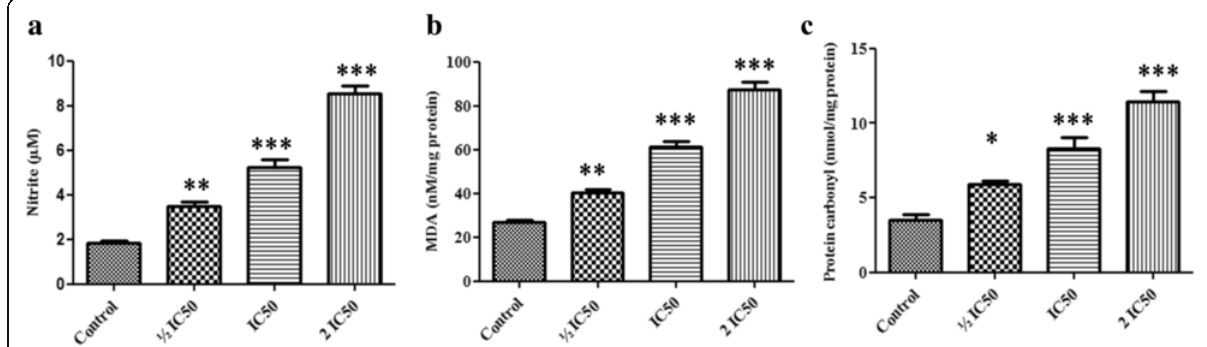
Fig. 7 Effect of F3 fraction on levels of a nitrite, b MDA and c protein carbonyl products in NCI-H358 cells. The results are expressed as the mean±SD of triplicate determinations, representative of three independent experiments. Significances indicated were in comparison to control (* p <0.05; ** p <0.01; *** p <0.001 vs.